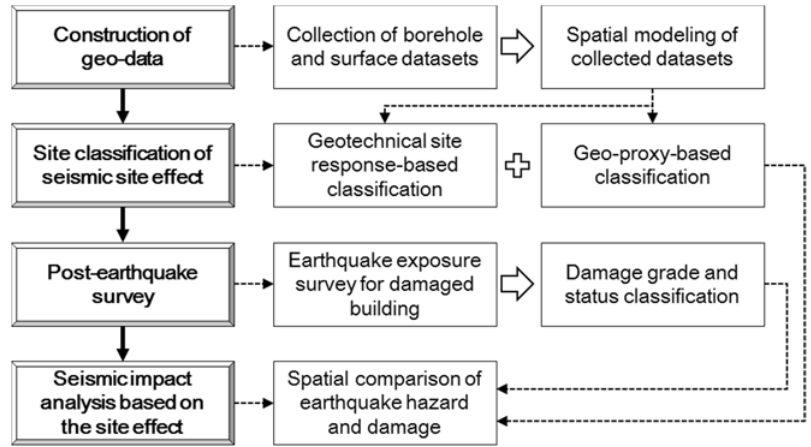
Figure 2. Post-earthquake survey framework for rapid earthquake damage estimation correlated with seismic site effects.